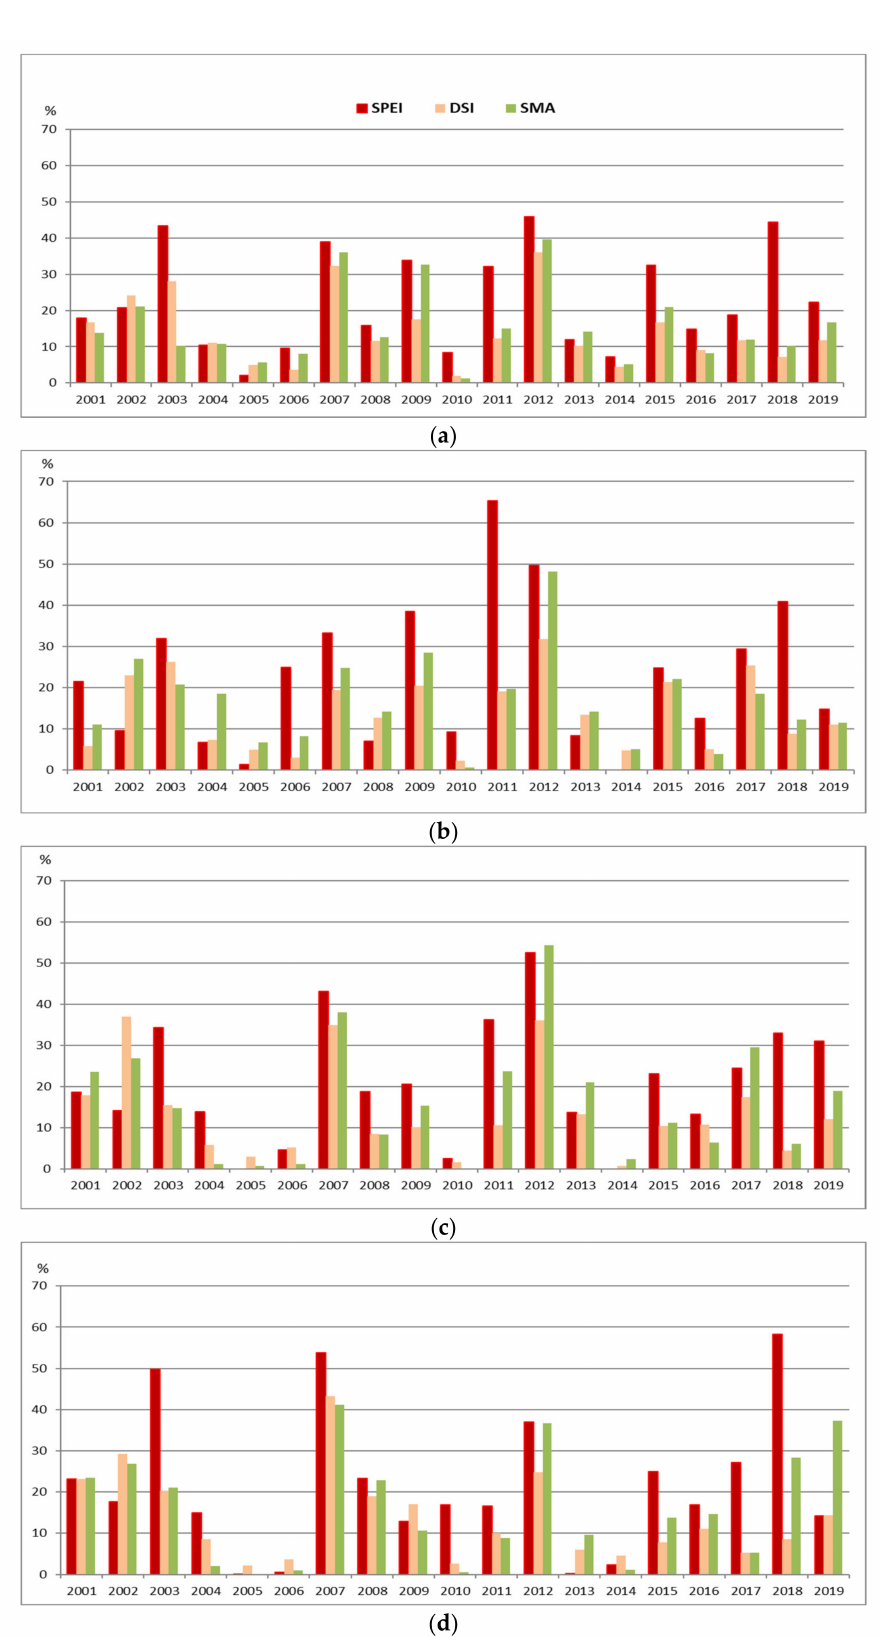
Figure 11. Mean of agricultural areas a ff ected by meteorological drought (SPEI), agricultural drought (DSI) and soil moisture deficit (SMA) between 2001 and 2019 (period of reference for SPEI was 1961–2019 and for DSI and SMA, 2001–2019); ( a ) Romania, ( b ) Banat Plain, ( c ) Oltenia Plain, ( d ) Baragan